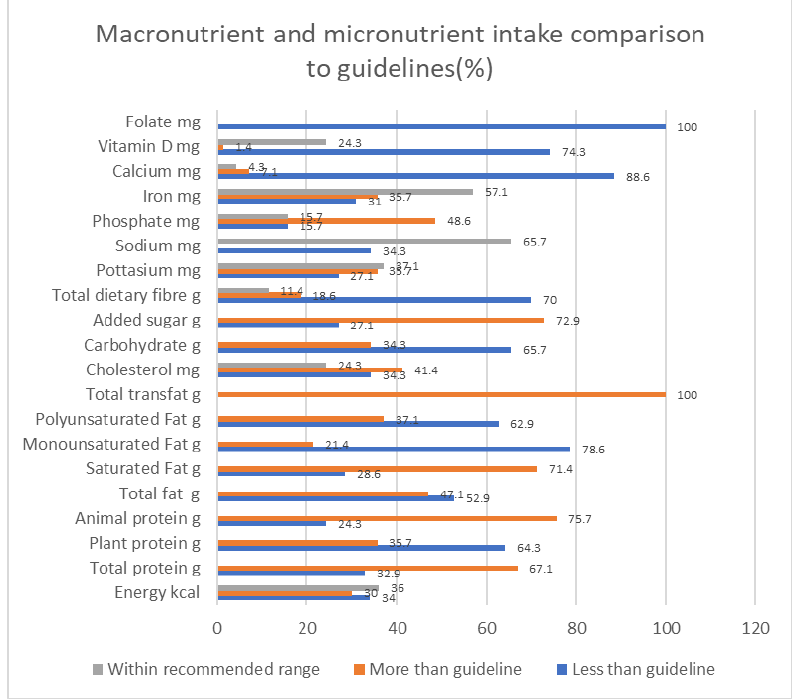
Figure 1. Nutrient intake compared to guidelines (% of participants).